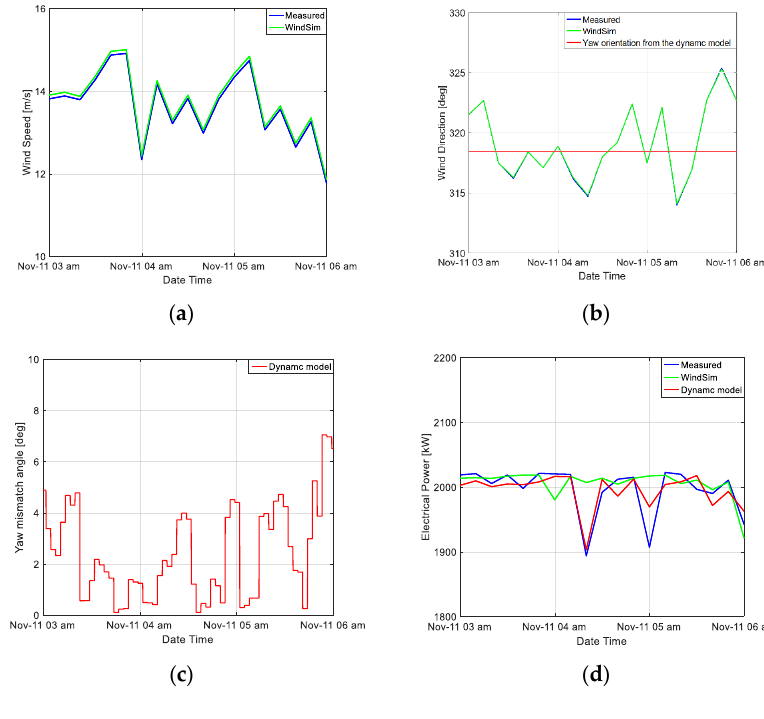
Figure 11. Comparison of the measured and predicted data for 3 h in August: ( a ) wind speed, ( b ) wind direction, ( c ) yaw mismatch, ( d ) electrical power, ( e ) generator torque, ( f ) pitch angle, ( g ) generator speed, ( h ) model